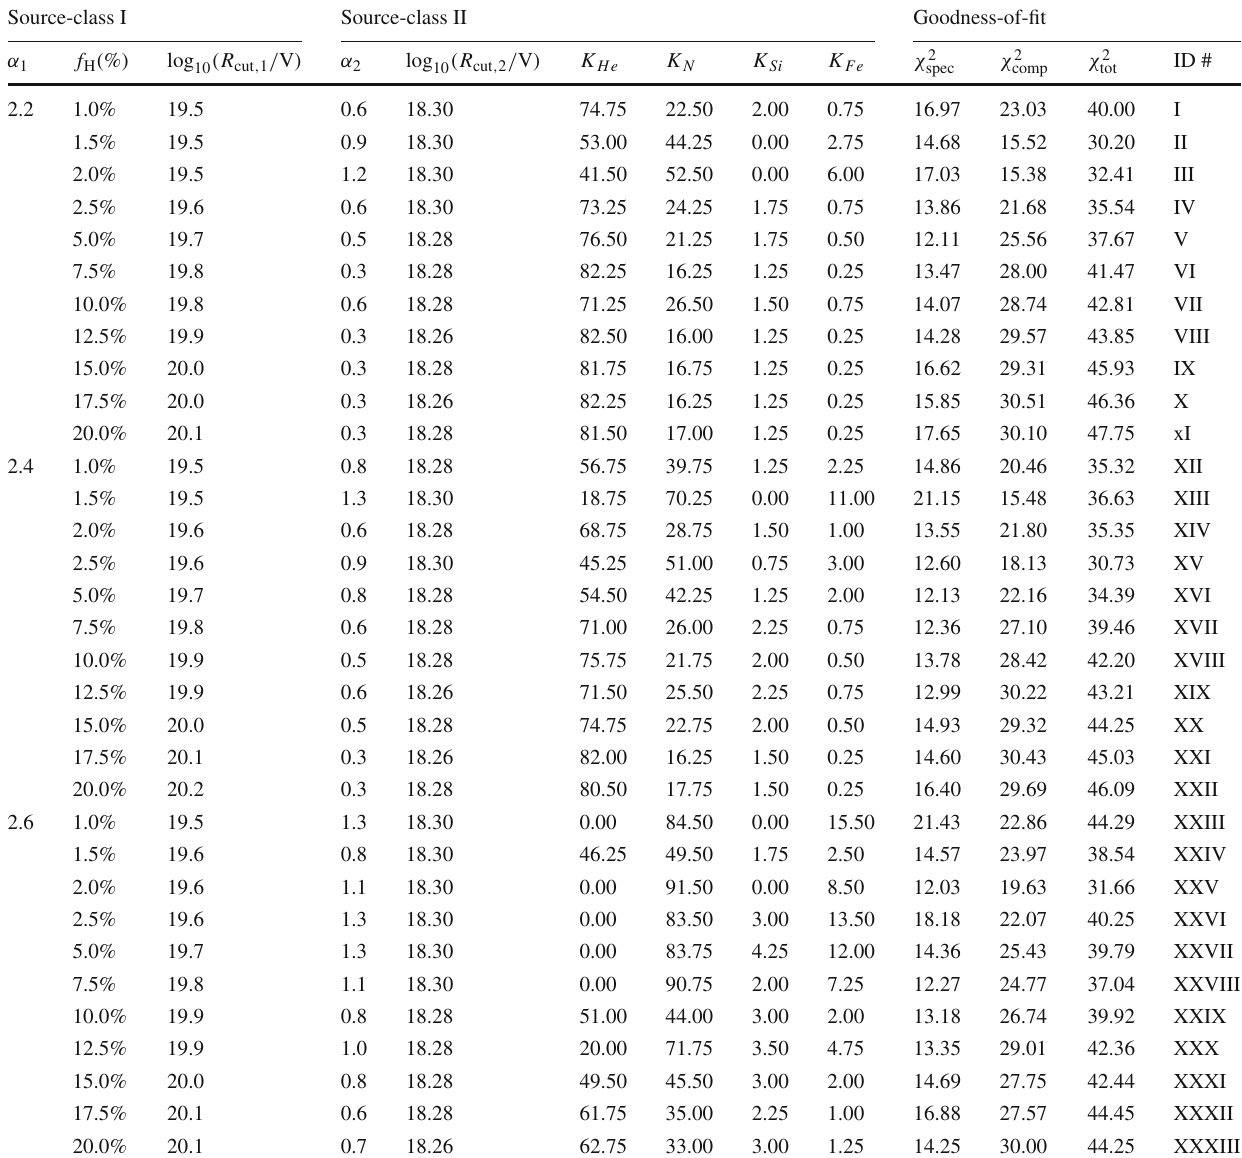
Table 2 Best-fits to UHECR spectrum and composition for two-population model without cosmological evolution Source-class I Source-class